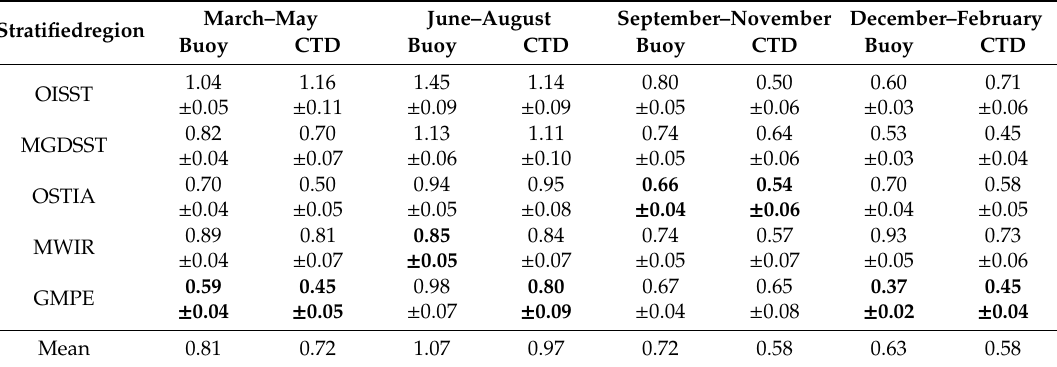
Table 5. Seasonal variations in the RMSD between the L4 gridded SST products (mostly based on satellite observation) and the in situ measurements (ocean buoys and research vessels) in the deep stratified region. The lowest RMSD in each column is given in bold